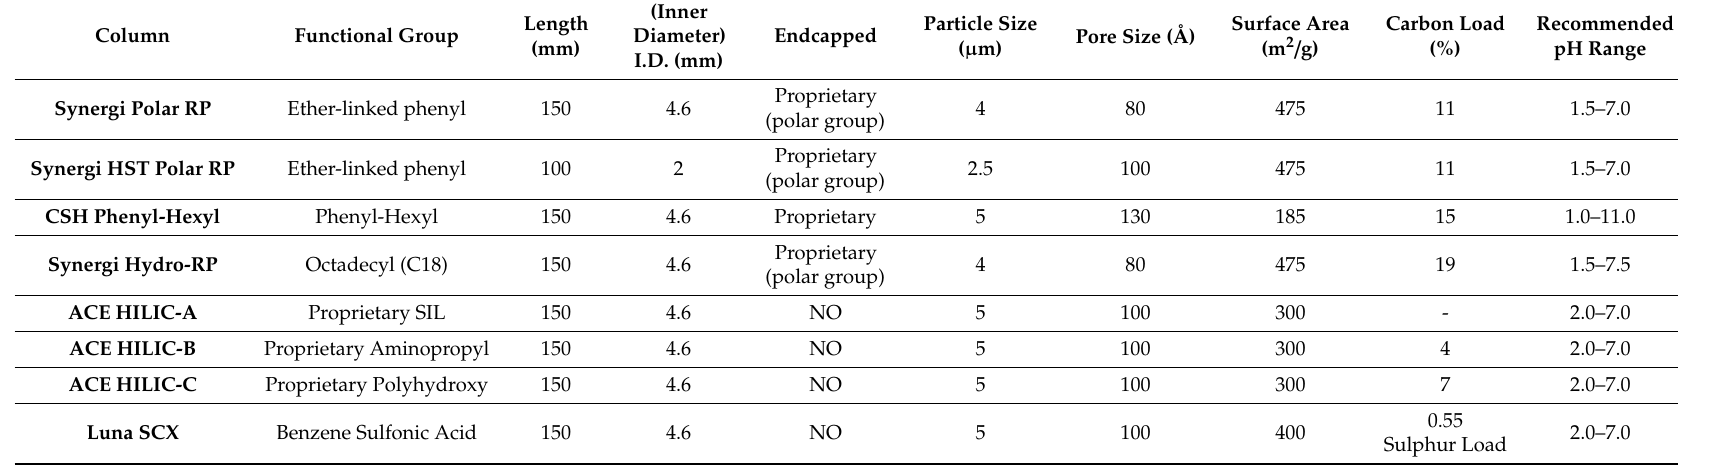
Table 1. List of tested columns and their physicochemical